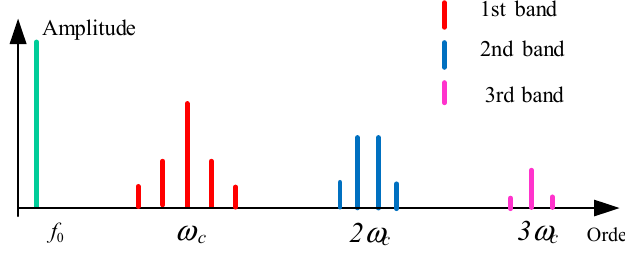
Figure 2. Frequency spectrum for classic two-level SPWM.